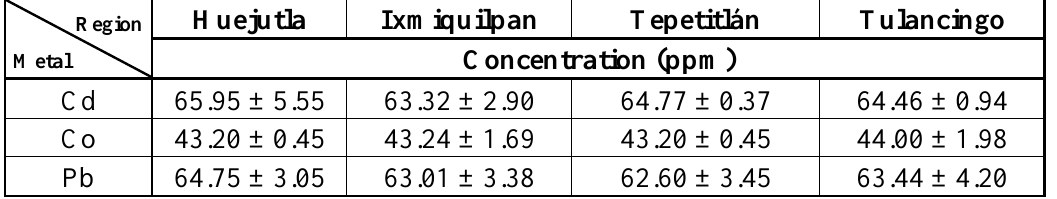
Table 1. Cd, Co, and Pb content in enamels used for the manufacturing of glass-clay containers.